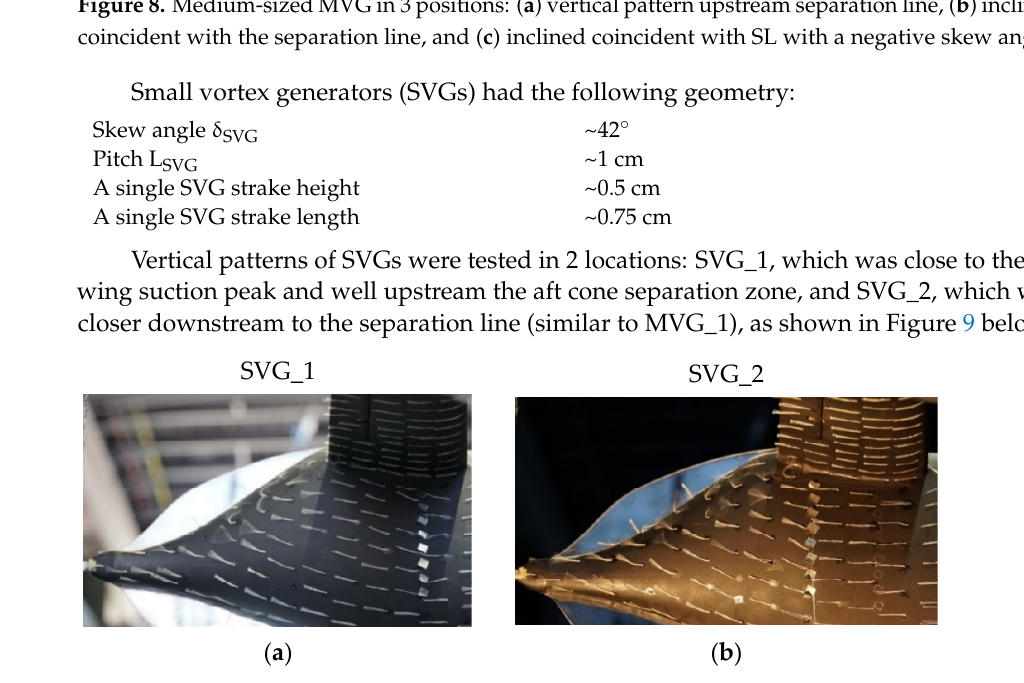
Figure 9. Small SVG in different locations: ( a ) near the aft wing suction peak, ( b ) near the separation line of the fuselage aft cone.